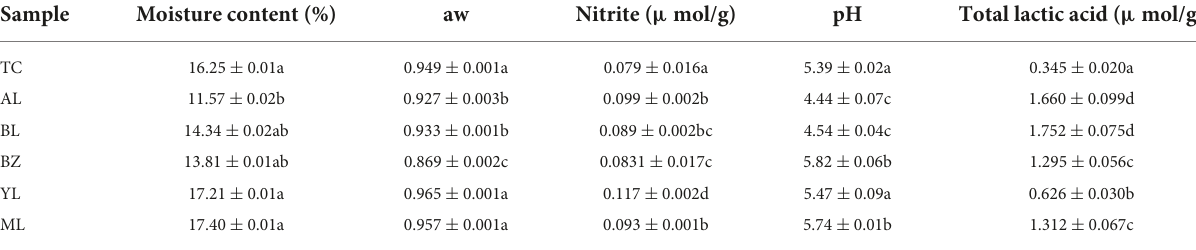
TABLE 1 Physical properties of smoked horse meat sausages from different regions.